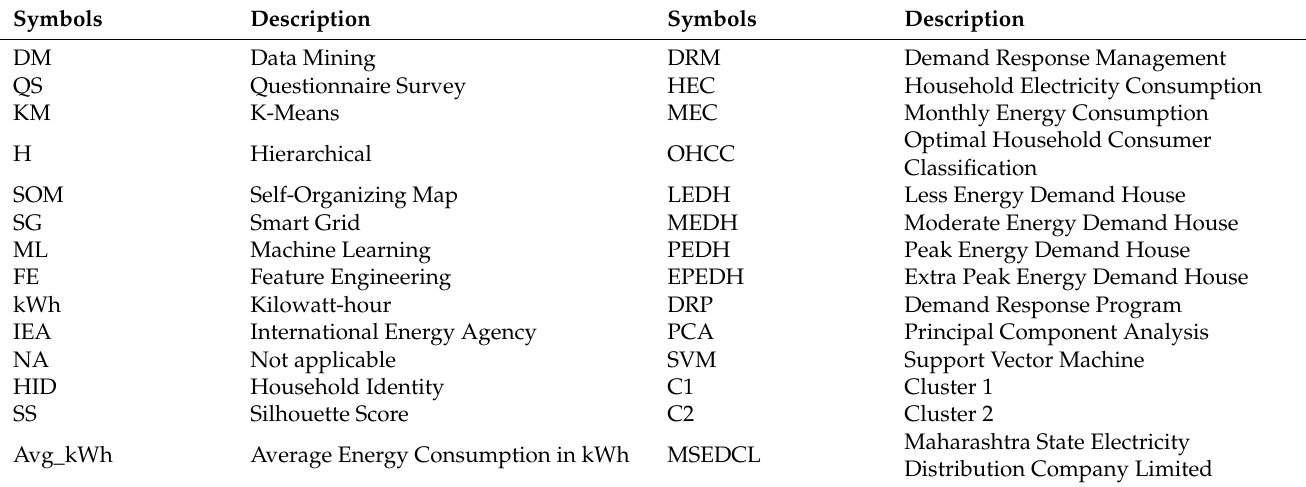
Table 1. Abbreviations